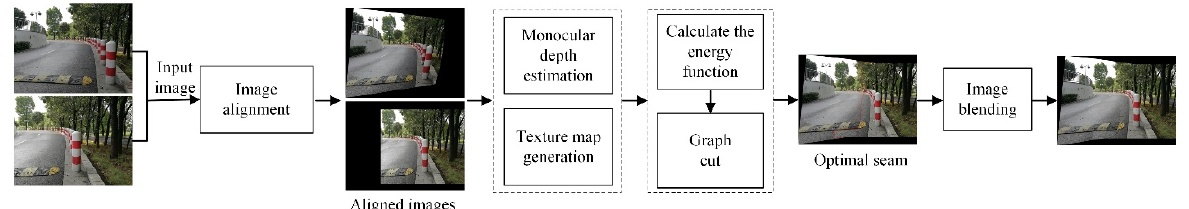
Figure 2. The framework of the proposed method.